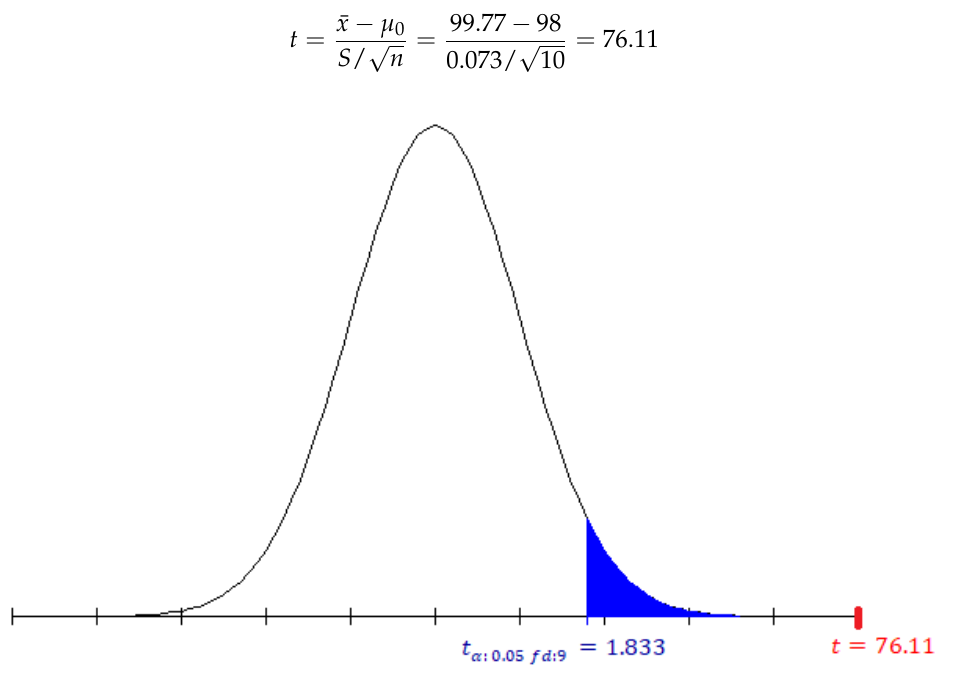
Figure 13. T-Student statistic from the approach proposed of experiment